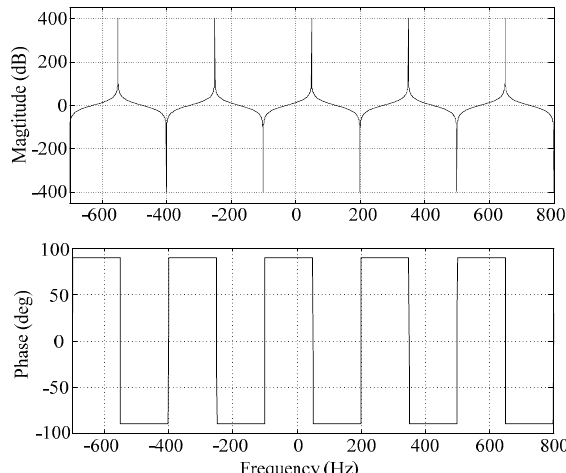
Figure 4. Bode plot of the proposed repetitive controller internal model.